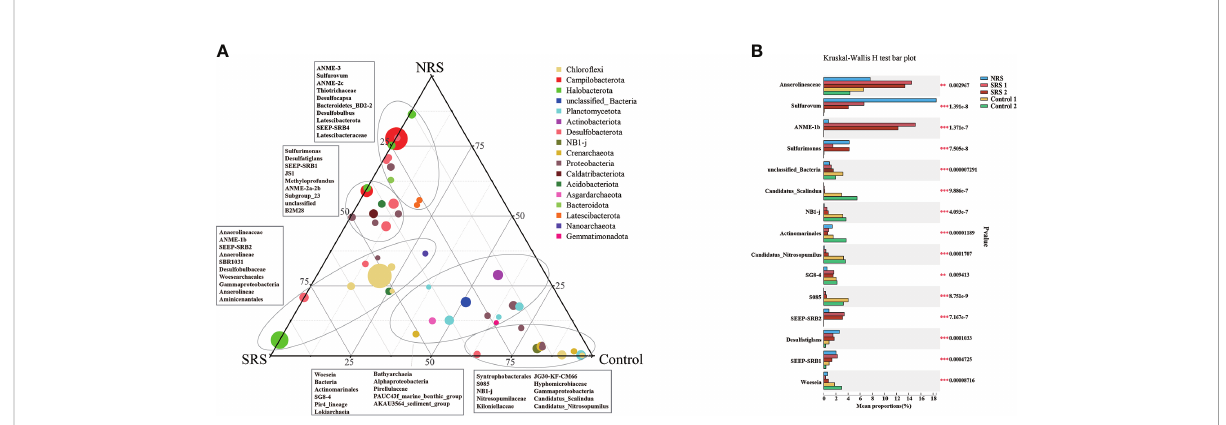
FIGURE 5 Distribution and relative sequence abundance of microbial groups between sampling sites. (A) Ternary plot showing the distribution and relative sequence abundance of the top 50 genera in all samples. Taxonomic af fi liations were indicated by colors, whereas the size of the symbol indicated the relative sequence abundance of each genus. (B) Multi-group comparison stamp showing the relative sequence abundance and distribution differences of the top 15 genera in all samples. ** 0.001 ≤ P value ≤ 0.01; *** P value ≤